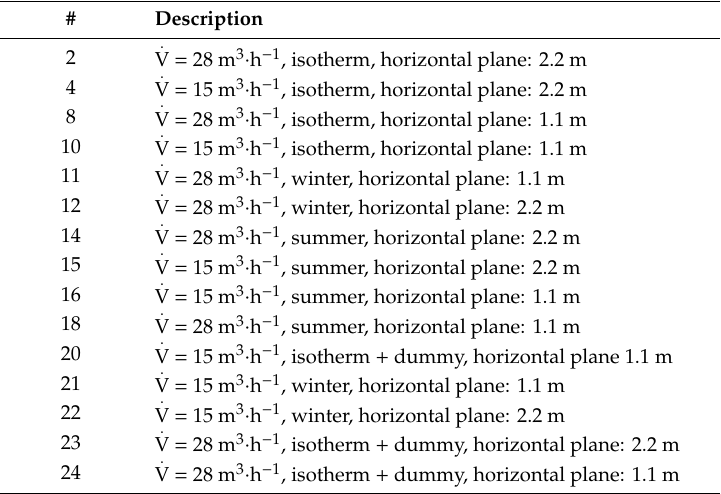
Table 4. Short description of the measurements